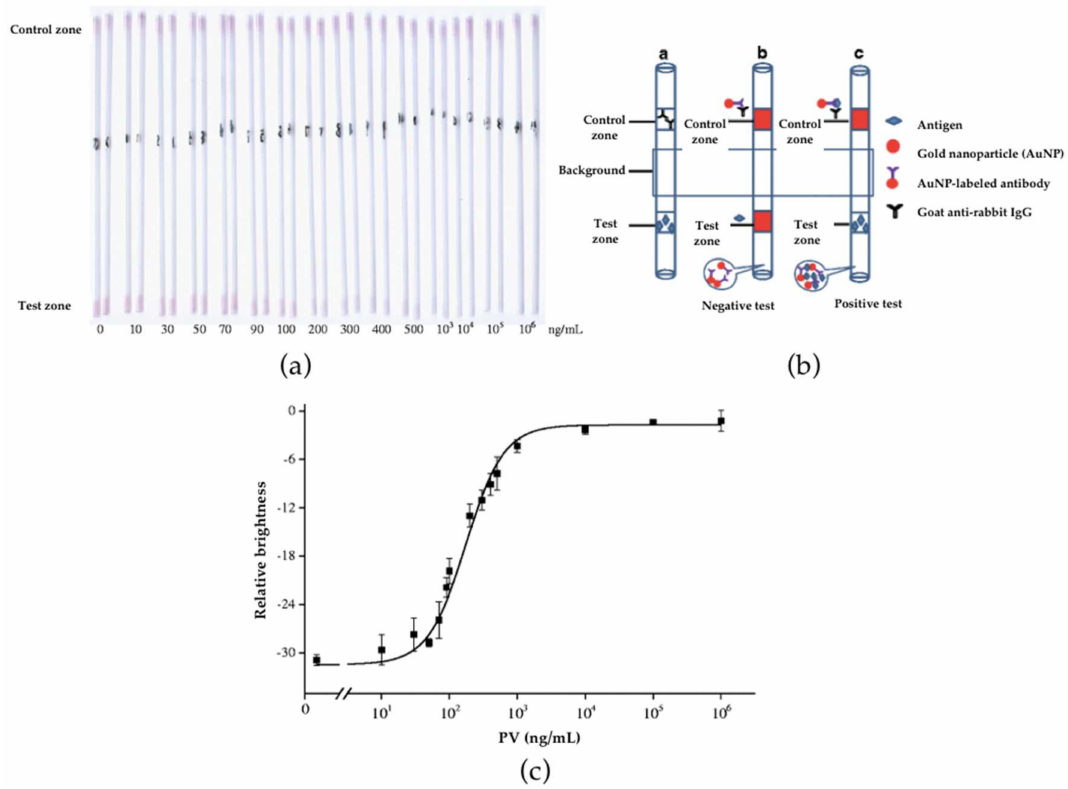
Figure 4. ( a ) Colloidal-gold immunochromatography assay in modified glass capillaries (CICA) results for parvalbumin (PV) in phosphate-buffered saline (PBS). PV concentrations tested ranging 0 to 106 ng/mL; ( b ) scheme of CICA system and ( c ) calibration curve obtained (n = 3). Reprinted with permission from [88]. Copyright 2014